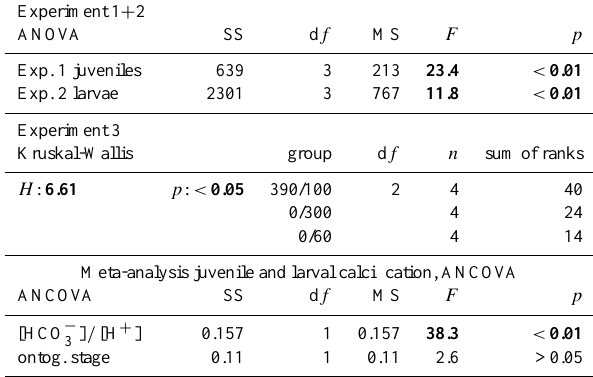
Table 2. Statistic: ANOVA, Kruskal-Wallis and ANCOVA of calci- fication rates against seawater [CO 2 − icant results in bold.